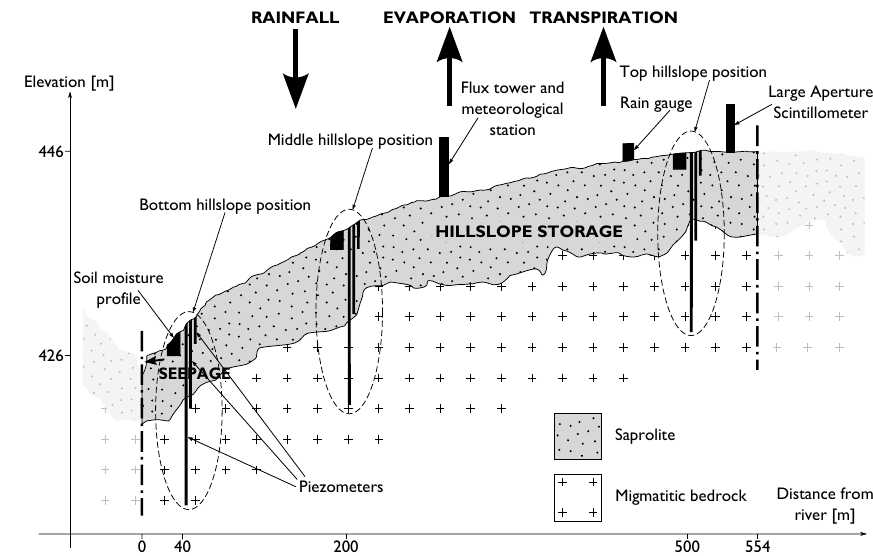
Fig. 2. Schematic hillslope representation (fluxes, water storage, available hydrologic sensors), assuming two axes of symmetry: the river at the bottom of the hillslope and the topographic divide at the top of the hillslope. Only the Large Aperture Scintillometer receiver is illustrated, the transmitter is at the symmetrical position on the opposite hillslope. Vertical stretching: